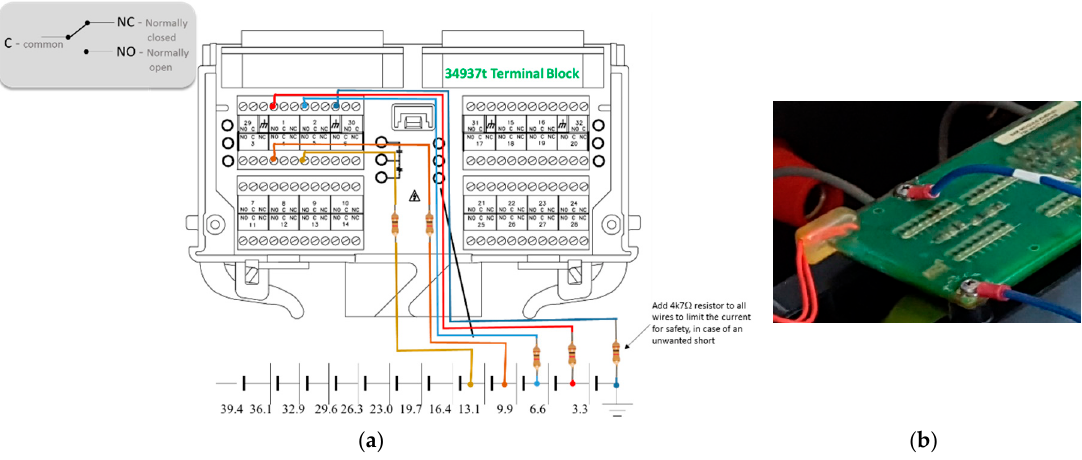
Figure A1. ( a ) A sketch for the design of the connector cable and the interfacing module; ( b ) a close up of the connector near the battery.